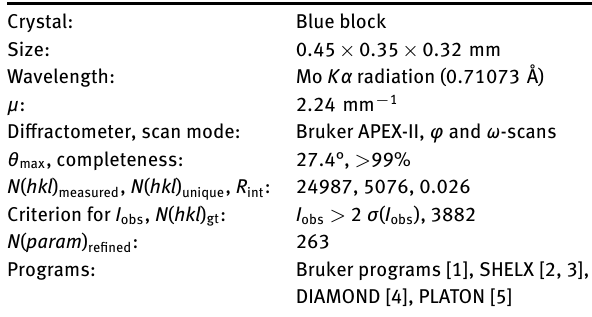
Table 2: Fractional atomic coordinates and isotropic or equivalent isotropic displacement parameters (Å 2